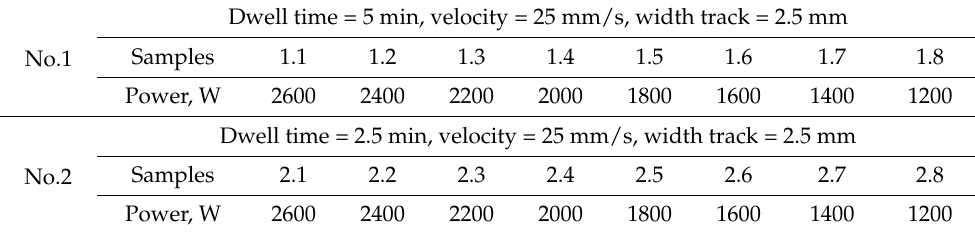
Table 2. The technological parameters of the deposited samples.